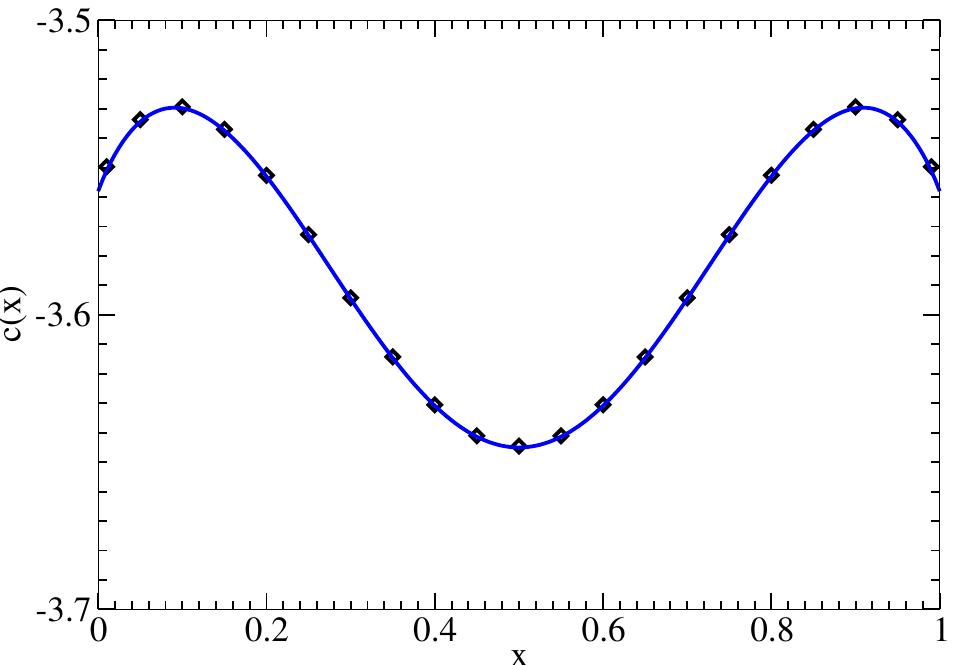
Figure 5 . A test of numerical vs. analytic extraction of the single log coefficient ¯ s ( x ) . The plot (cid:0) (cid:1) is of c ( x ) ≡ ¯ s ( x ) − ln − 1 + 1 + 1 vs. x , where the subtraction of the logarithm (based on the x 1 − x “educated guess” for ¯ s ( x ) in ref. [20]) makes the fine details more visible by removing the logarithmic divergence of ¯ s ( x ) as x → 0 or 1 . The numerical extraction of c ( x ) is shown by the diamonds and is the same as figure 20 of ref. [20] except corrected by a 4 π downward shift, as explained in appendices A and E.7 of this paper. (We have also very slightly improved the accuracy.) The solid curve is our analytic result, based on